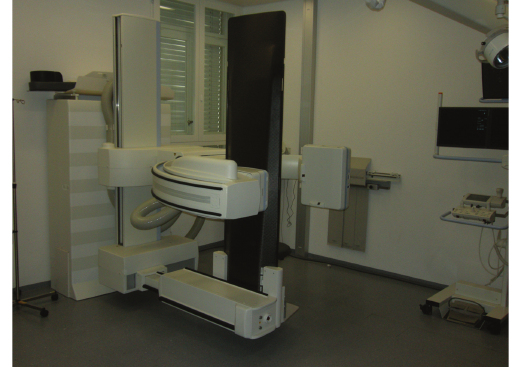
Figure 1: The myelography workplace. The table is tiltable by more than 90 ◦ so that a head-down position can be achieved.